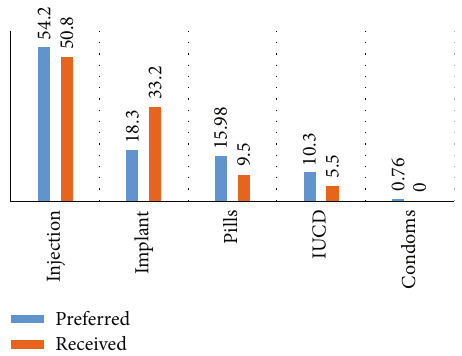
Figure 2: The primary preferences and utilization of postabortion contraceptive methods among women who received abortion care services at the health facilities in Ambo town, Oromia region, Ethiopia,